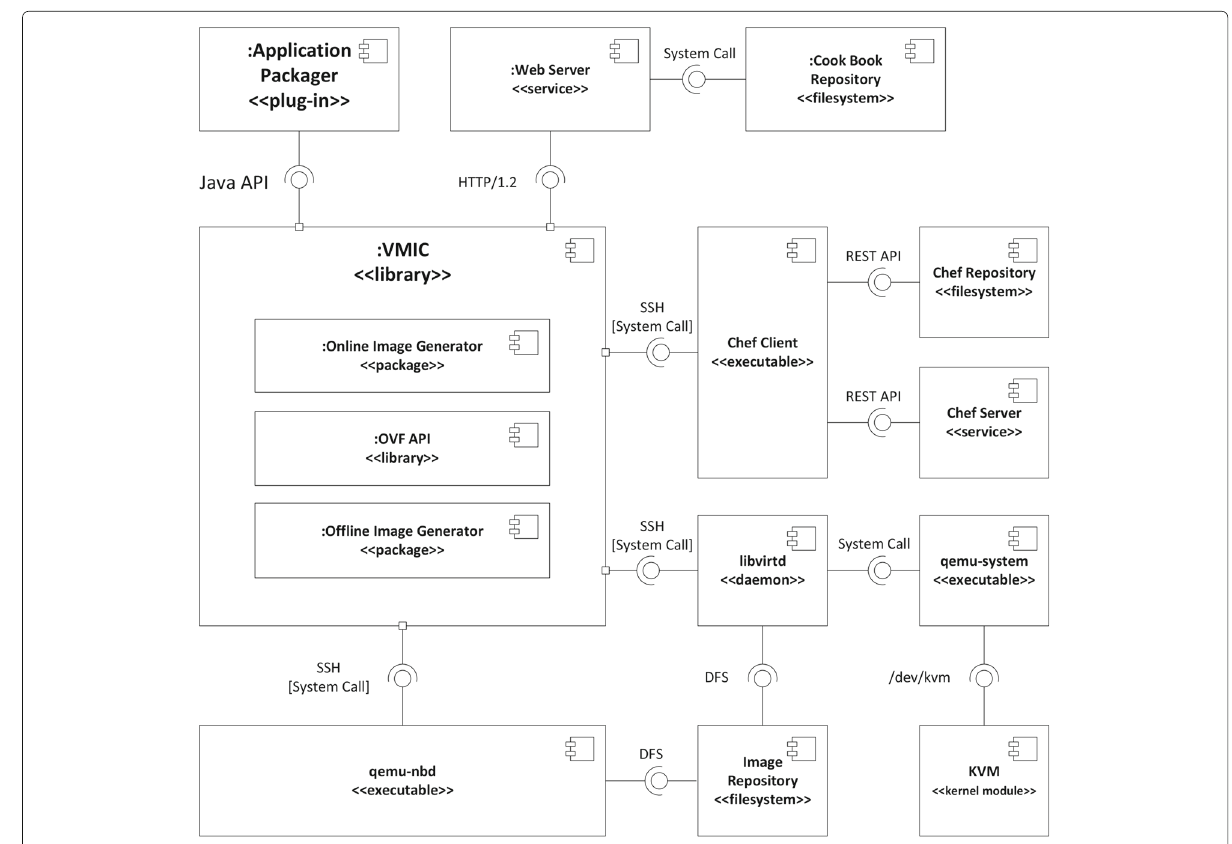
Fig. 5 VMIC Component